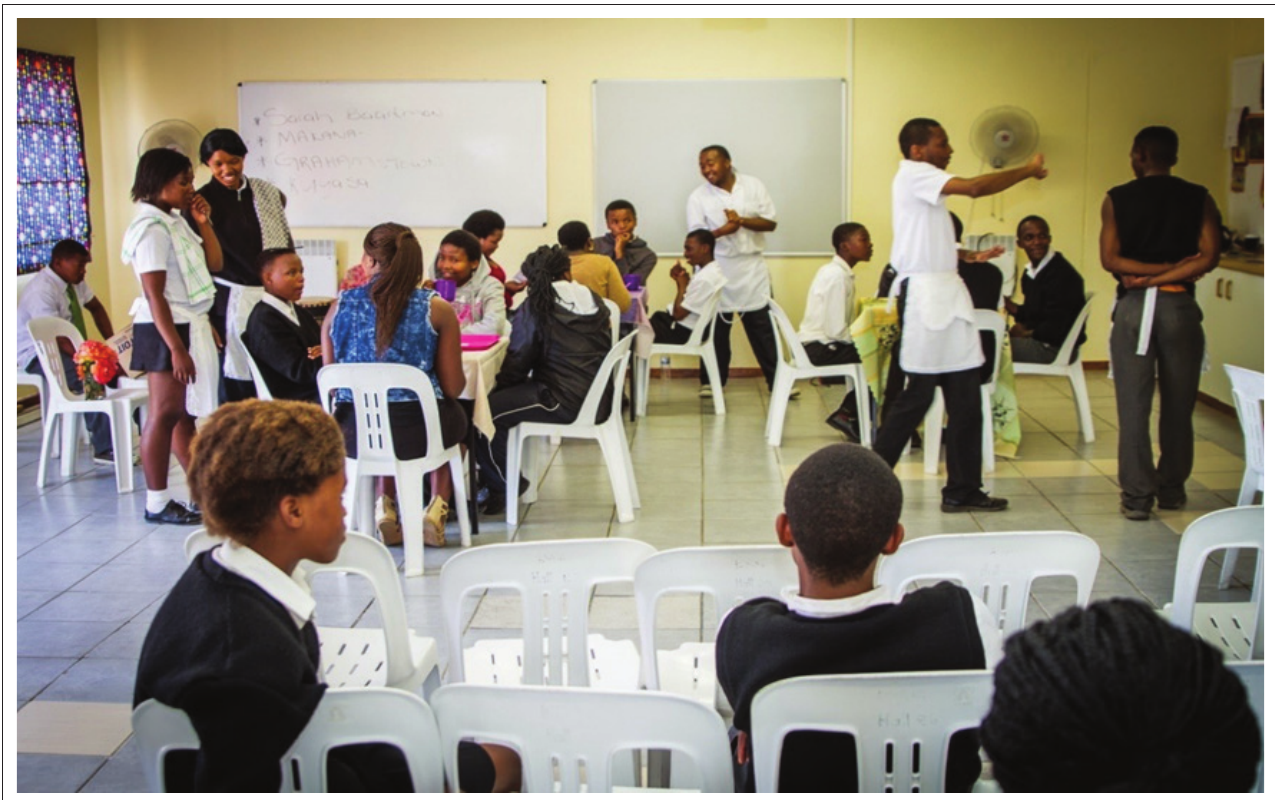
FIGURE 3: Dress rehearsal for the school staff and fellow peers (Photo credit: Paul